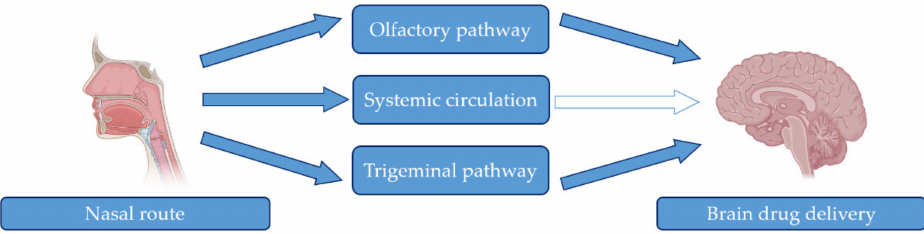
Figure 5. Nose-to-brain drug